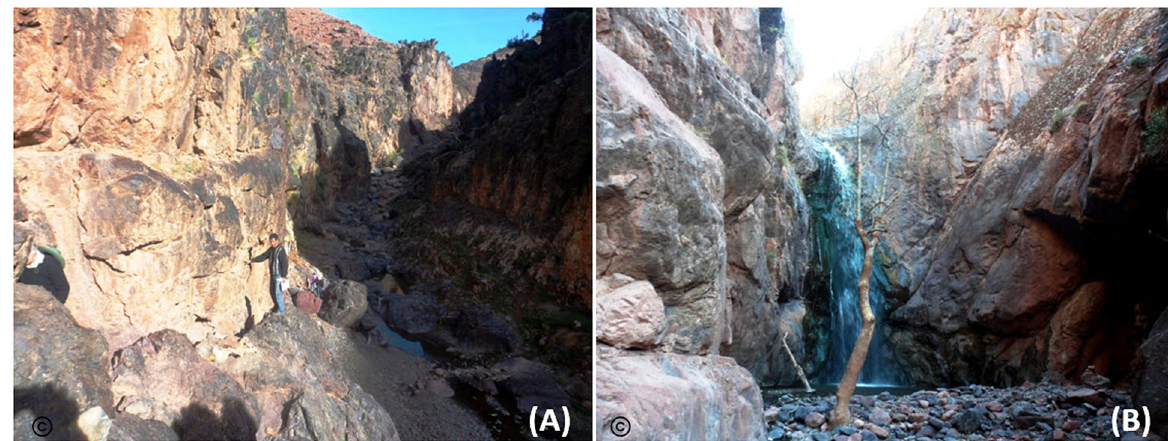
Fig. 9. Angular unconformity between the Paleozoic and Precambrian (PIII) with its stratigraphic column according to Monbaron and Monbaron (2015).